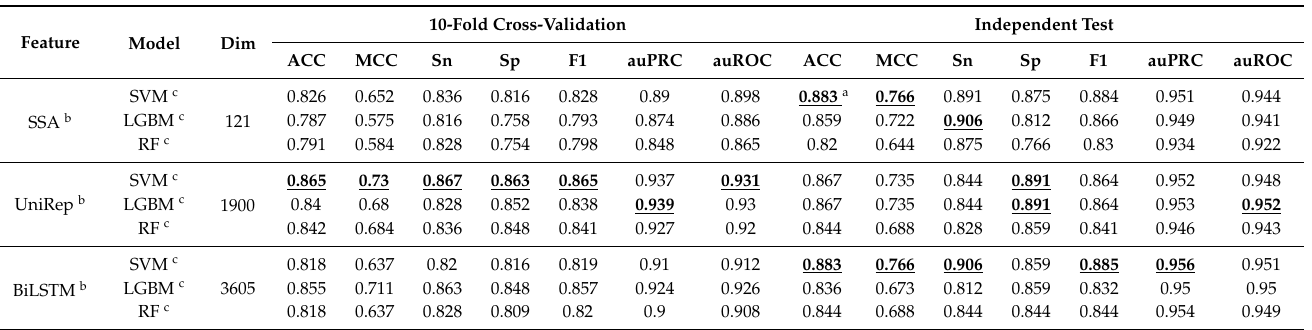
Table 1. Performance metrics of three different deep representation learning features using three machine learning